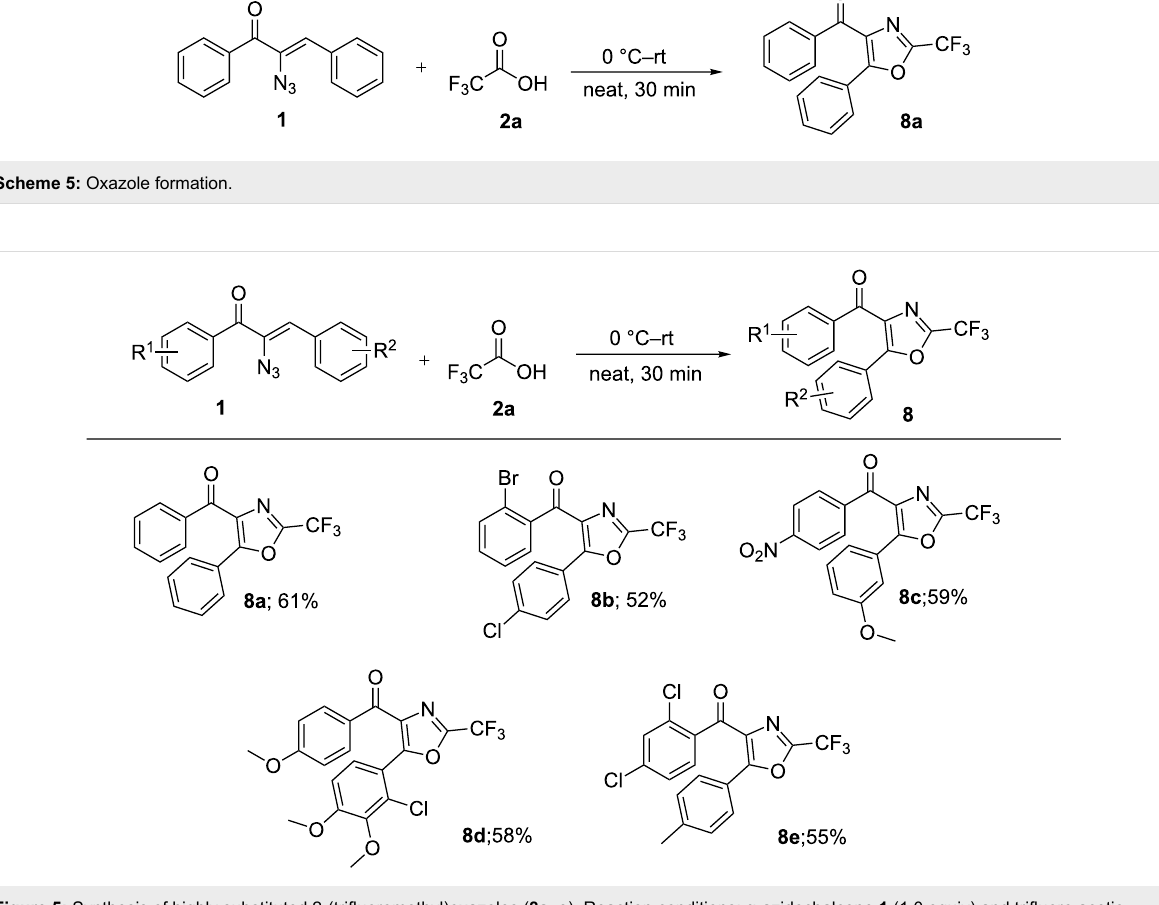
Figure 5: Synthesis of highly substituted 2-(trifluoromethyl)oxazoles ( 8a–e ). Reaction conditions: α -azidochalcone 1 (1.0 equiv) and trifluoro acetic acid 2a (2.0 equiv), 0 °C–rt, 30 min.